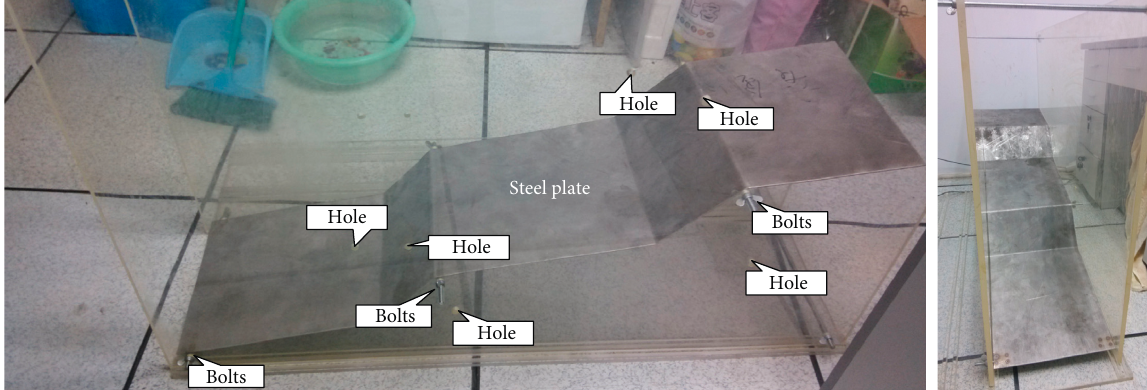
Figure 8: Model test tank which can alter the angle.